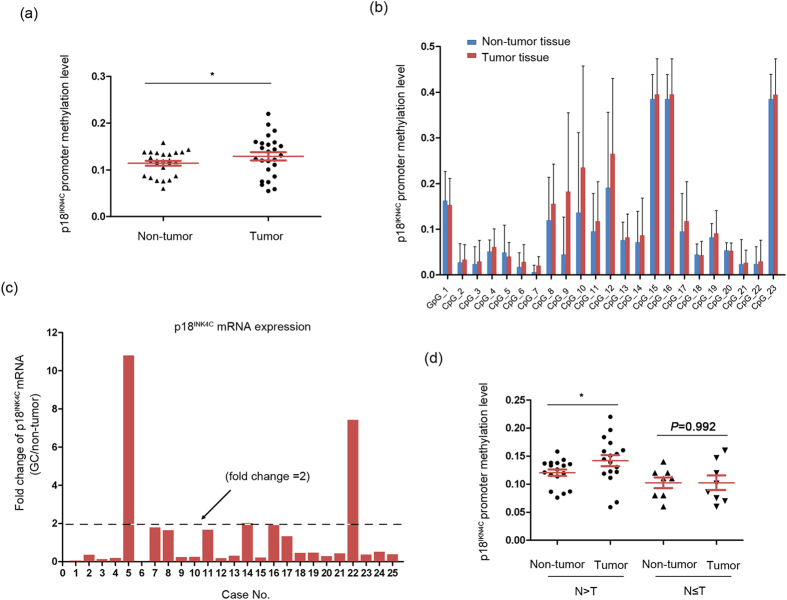
The methylation status of p18INK4C promoter in clinical GC specimens.(a) Scatter plots of p18INK4C promoter methylation levels in 25 paired GC tissues (T) and adjacent non-tumor tissues (N) (*P < 0.05). In both panels, the red lines indicate the mean ± SEM. (b) The methylation levels of 23 CpG sites in 25 paired GC tissues and adjacent non-tumor tissues. (c) qPCR analysis showing p18INK4C mRNA levels in 25 paired clinical GC specimens. The value (defined as “fold change”) indicates the ratio of the p18INK4C mRNA expression levels in the GC versus non-tumor tissues. (d) A total of 25 paired clinical GC specimens were divided into two subgroups based on their relative p18INK4C mRNA expression levels. Tissues with low p18INK4C expression (defined as a less than 2-fold decrease) were assigned to the N > T group, while the remainder were classified into the N ≤ T group. The tissues with low p18INK4C expression display higher methylation levels in tumor tissues compared with adjacent non-tumor tissues (*P < 0.05).